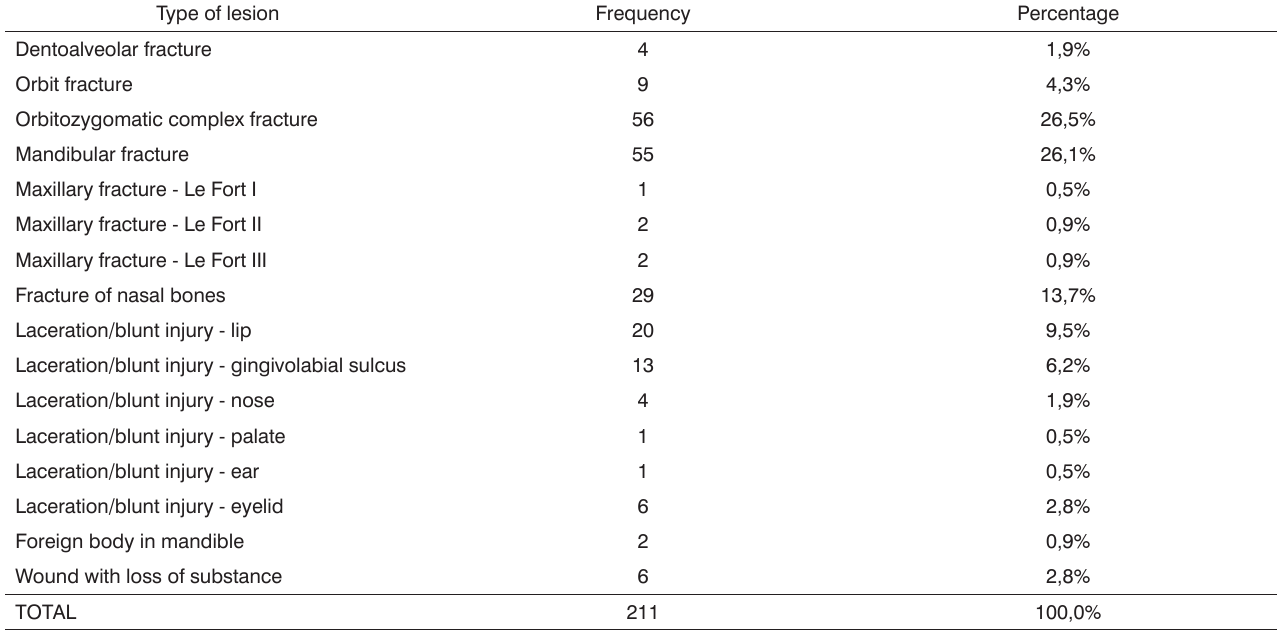
Table 6. Distribution and frequency of the population per characteristics and anatomical sites of lesions.